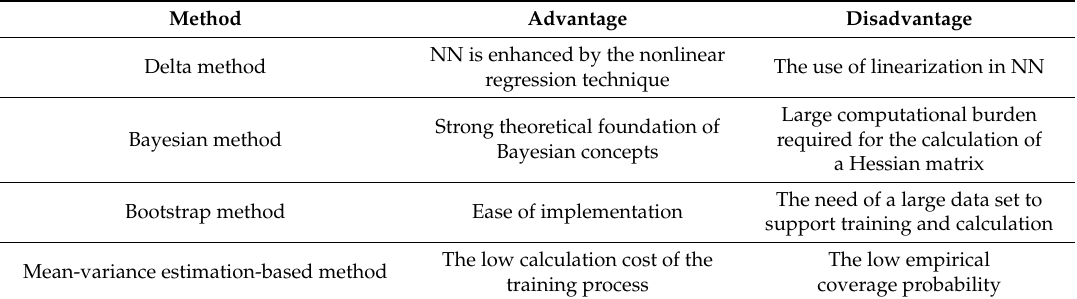
Table 1. The features of four traditional neural network (NN)-based predication interval (PI) construction methods